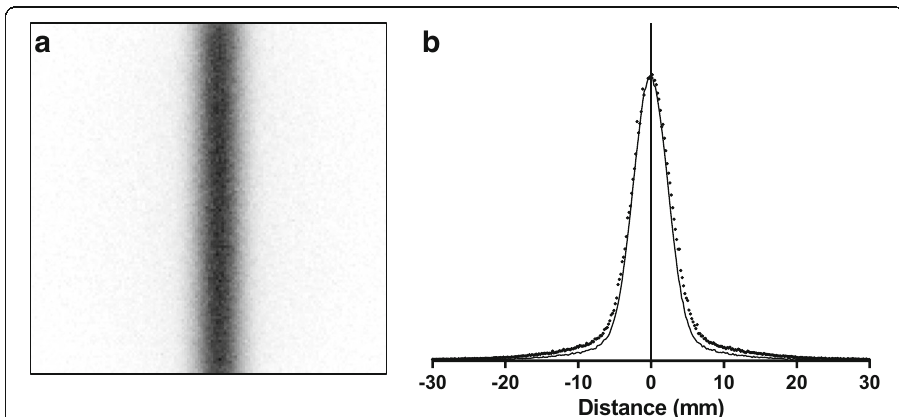
Fig. 11 Monte Carlo simulated line source image ( a ) and line profile compared to measured ( b ). Simulated assuming 100% density and nominal septal